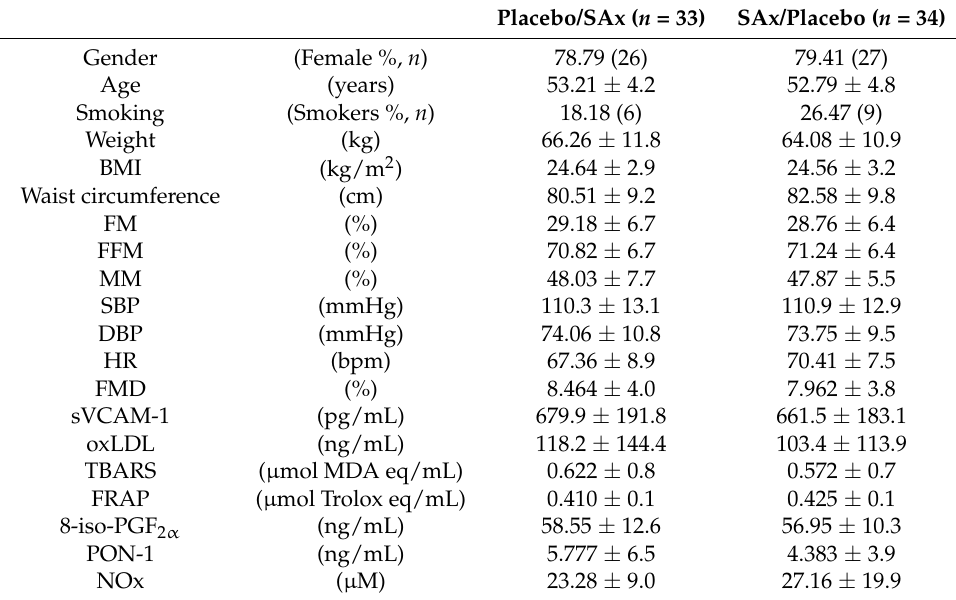
Table 1. Baseline characteristics of the subjects.